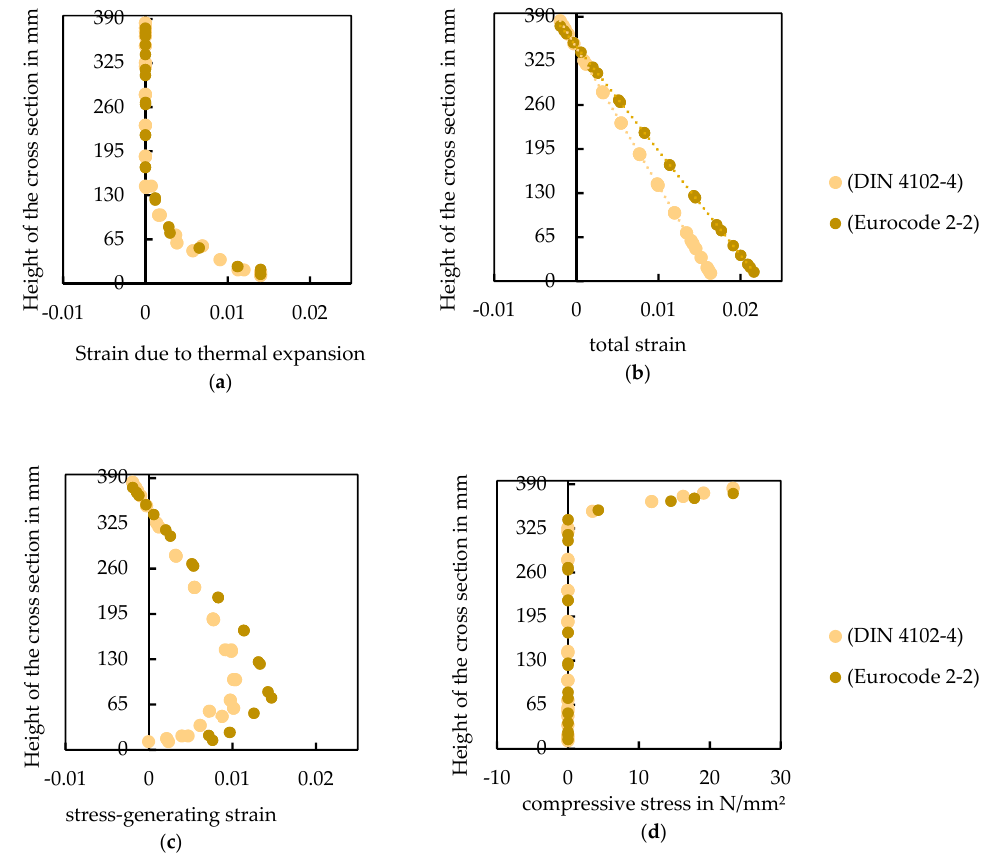
Figure 14. ( a ) Strain due to thermal expansion, ( b ) Total strain, ( c ) Stress-generating strain, ( d ) Com-